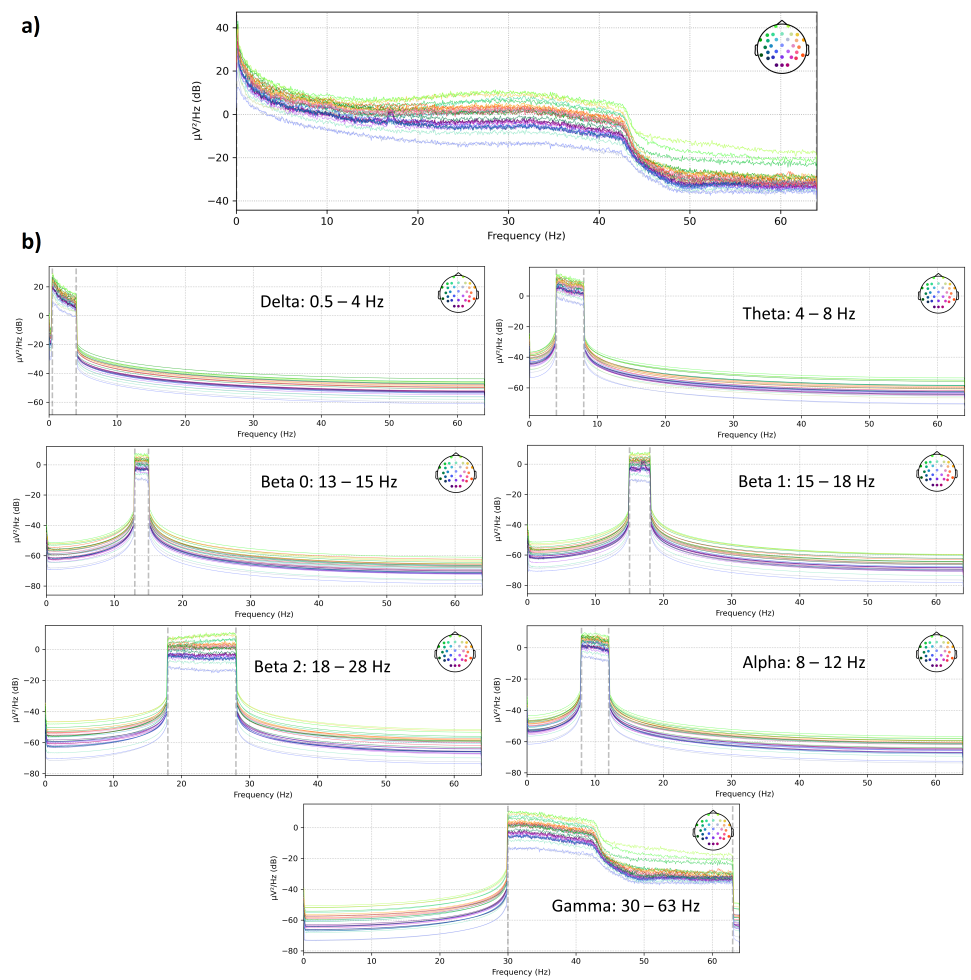
Figure 9. Example of ( a ) the power spectral density for each electrode and ( b ) power spectral density after applying filters for individual frequency bands (participant